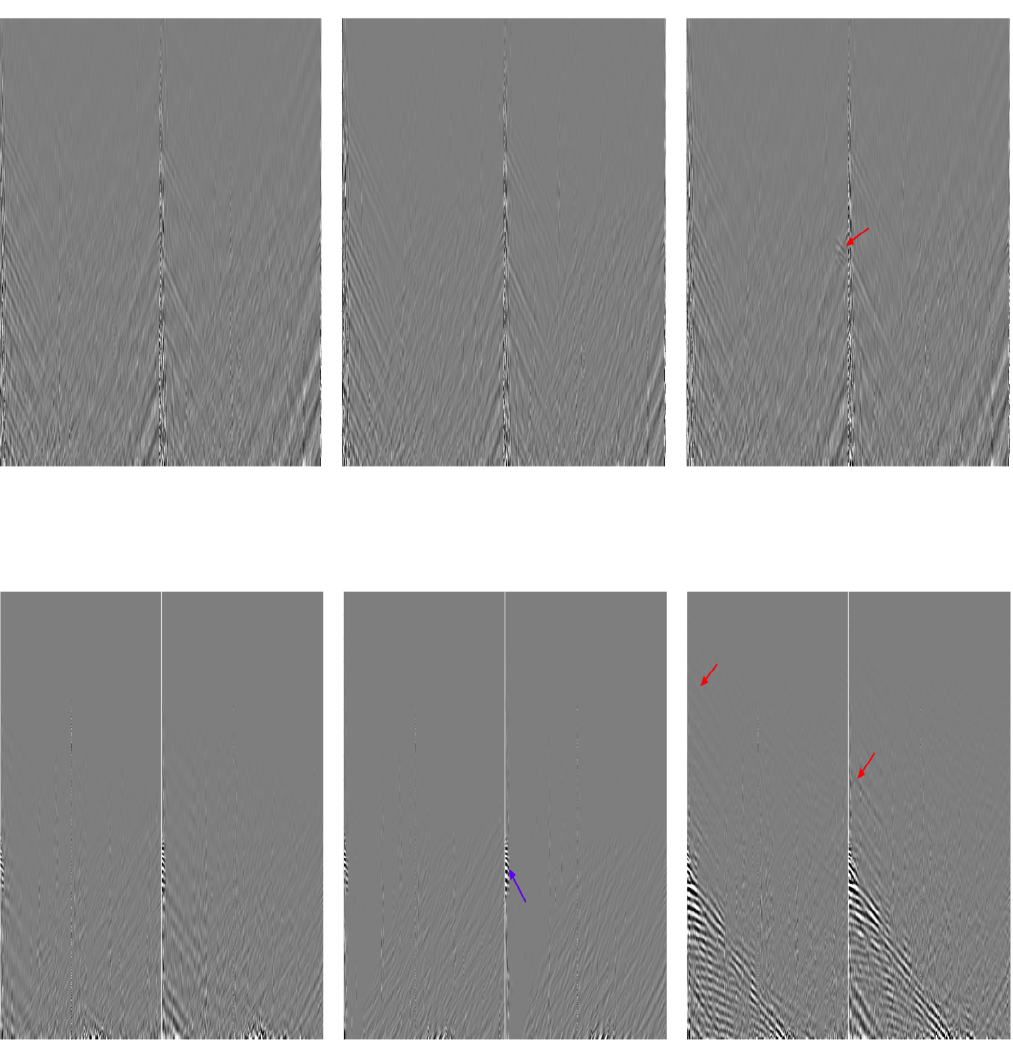
Figure 4. Residual seismic data after prod, mild, and harsh filtering processes (from left to right) of two projects: 4376exm ( Top ) and 4354pgs ( Bottom